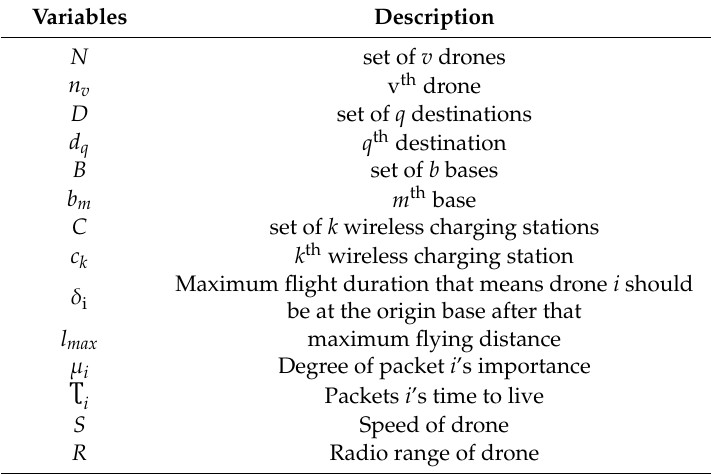
Table 1. Summary of notations.